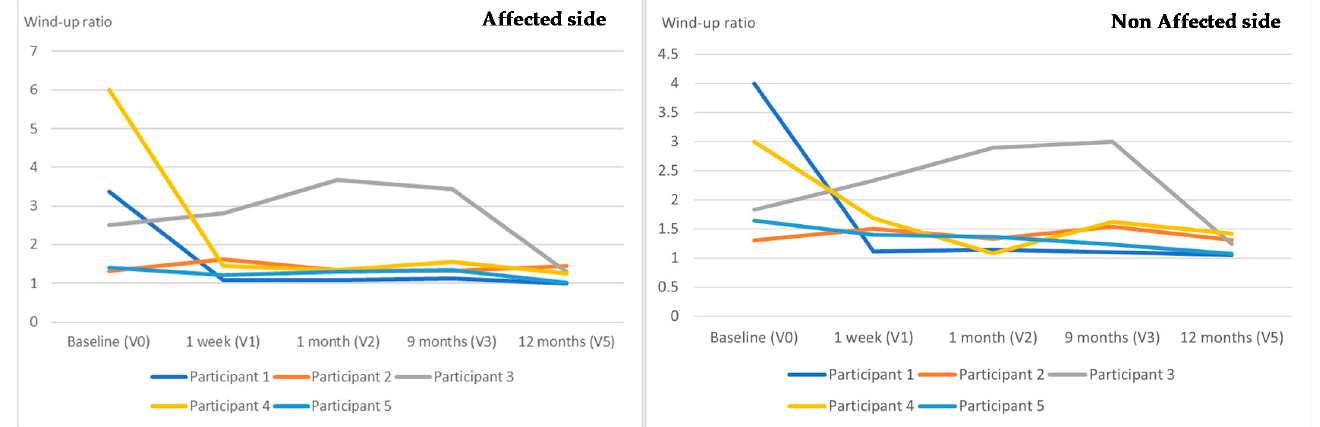
Table 5. Changes (percentage) in self-reported measurements scores.